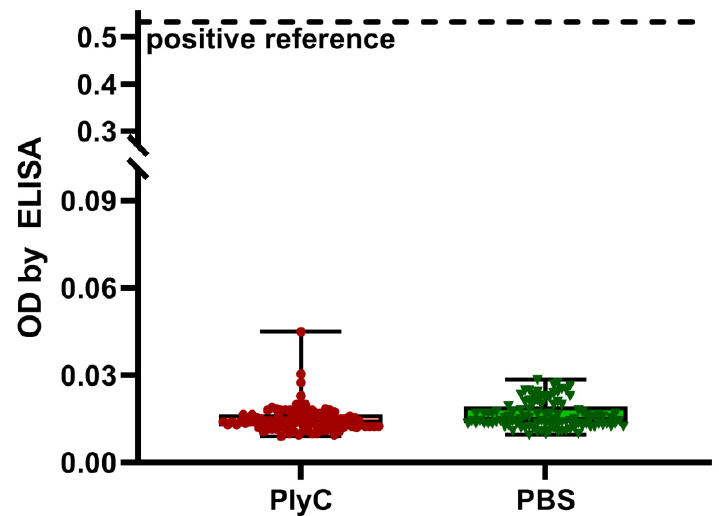
Figure 5. PlyC-specific IgE in a human population. Sera from human participants ( n = 104) were tested by ELISA for reactivity to PlyC or PBS as a control. A positive reference signal contained wells coated with human IgE. No statistically significant difference was detected between PlyC and PBS reads ( p > 0.1), despite one sample in the PlyC group determined to be an outlier. Two technical replicates were completed.